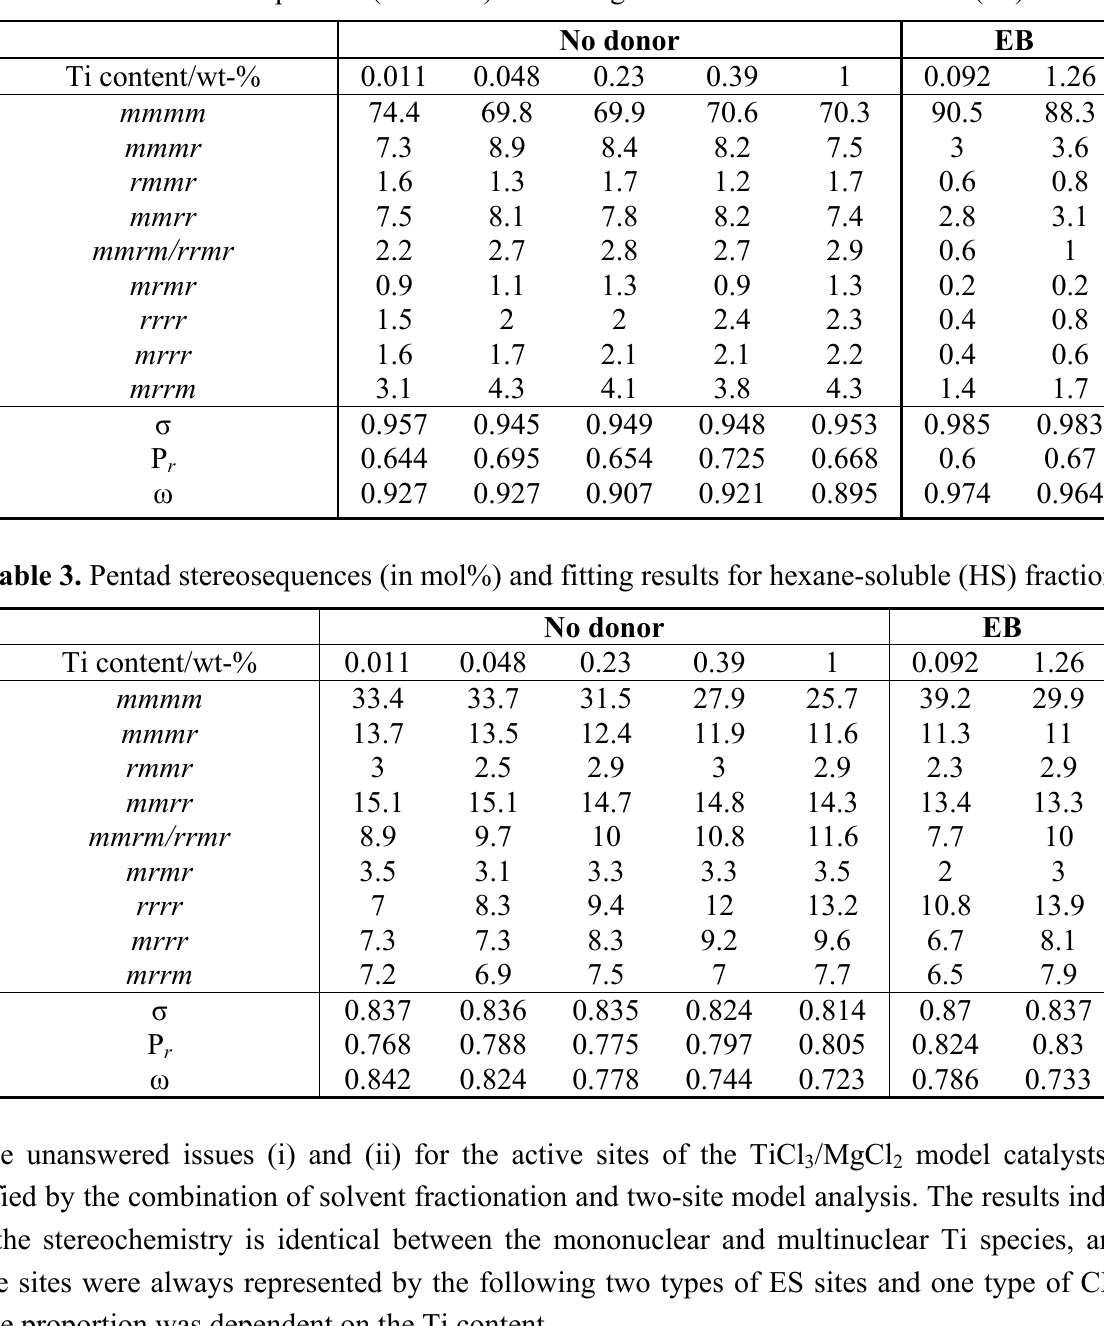
Table 2. Pentad stereosequences (in mol%) and fitting results for hexane-insoluble (HI) fractions.